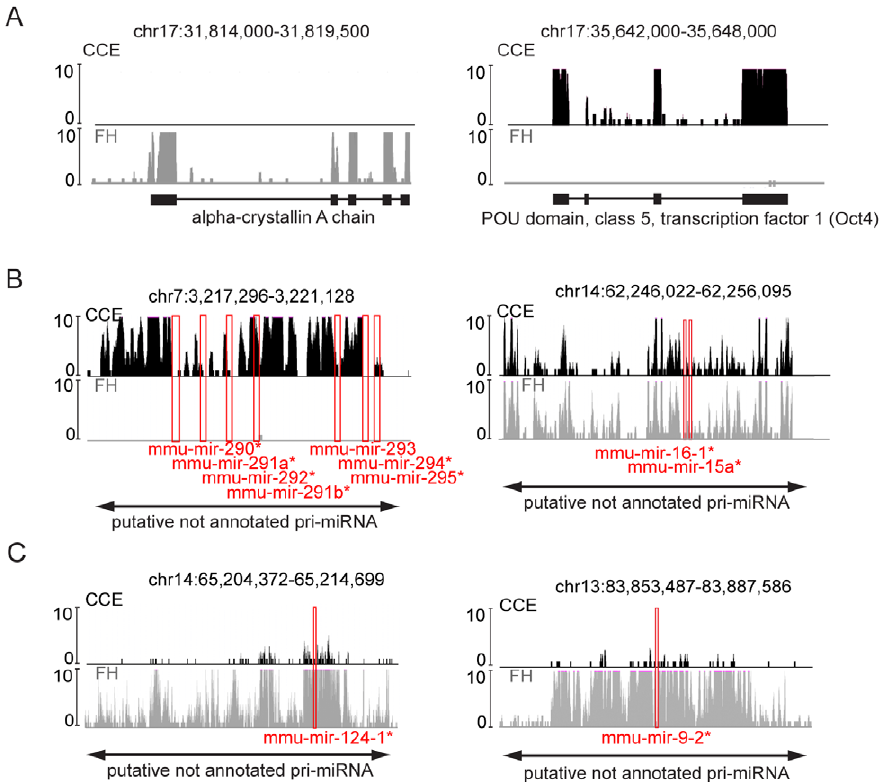
Figure 4. Ribo-depleted RNA-Seq detects tissue specific expression of known protein-coding and non-coding genes. ( A ) UCSC genome browser (http://genome.ucsc.edu/, mm9) screen shots of RNA-Seq data for CCE (black, top) and FH (grey, bottom). The genome position is given on top, black or grey bars indicate the number of sequence tags (tag numbers . 10 are cut off) at this position. The position of RefSeq genes (black line) with exons (black boxes), are shown below with the gene name. Left: the alpha-crystallin A chain gene is specific for the mouse eye and therefore sequence tags over exons (indicating gene expression) are only found in FH and are absent from CCE. Right: the well-known stem cell marker Pou5f1 ( Oct4 ) shows sequence tags over exons only in CCE but not in FH. ( B ) Putative pri-miRNAs indicating either the specific expression of all miRNAs of the cluster in CCE and the . 10 fold reduced expression in FH (left) or the similar expression of the two miRNAs in the region in CCE and FH (right). Red boxes indicate the position of annotated miRNAs (http://genome.ucsc.edu/, mm9) with the name given below. Asterisks mark miRNAs overlapped by a low number of sequence tags. The position of the putative pri-miRNA, not annotated in the RefSeq database, is shown at the bottom by a double-headed arrow. Details as in (A). ( C ) Putative pri-miRNAs indicating the . 10 fold increased expression of the single miRNAs of the respective cluster in FH compared to CCE. Details as in (A). Note that in A, B, and C RiboMinus data is shown and that the Ribo-Zero data produced similar results (data not